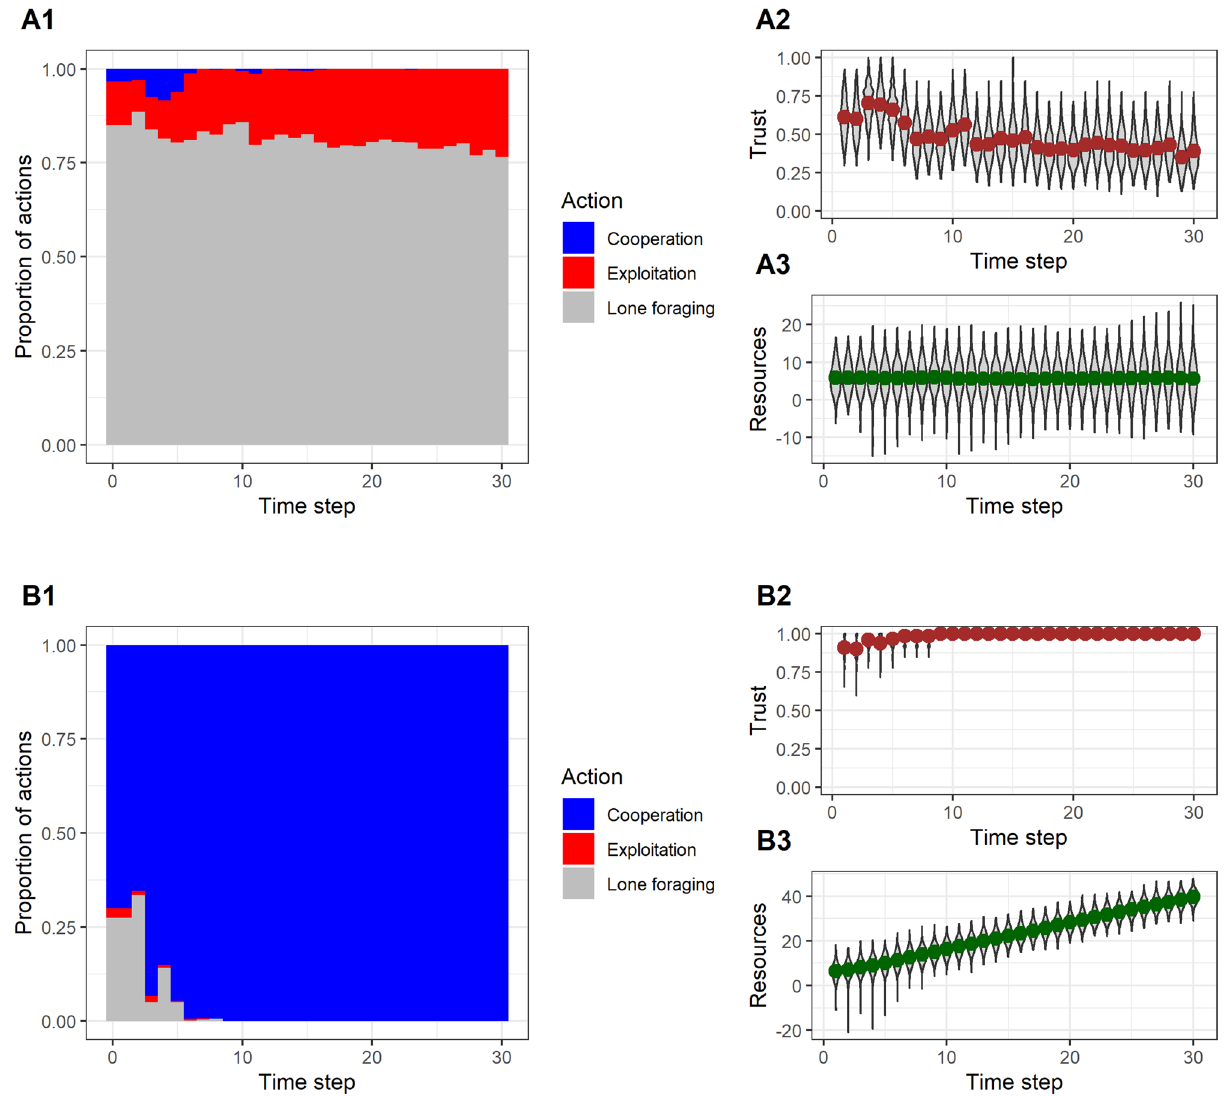
resources never increase ( A3 ), and a subgroup of the population is left below the threshold seeking to exploit. Simulation initialised with μ = 5.5, σ = 4 and all other parameters at their default values. ( B ) The virtuous circle. Exploitation is sufficiently rare from the outset ( B1 ) that trust is high ( B2 ) and individuals switch from lone foraging to cooperation. This drives an increase in resources, eventually lifting almost all individuals above the threshold. Simulation initialised with μ = 5.5, σ = 3 and all other parameters at their default